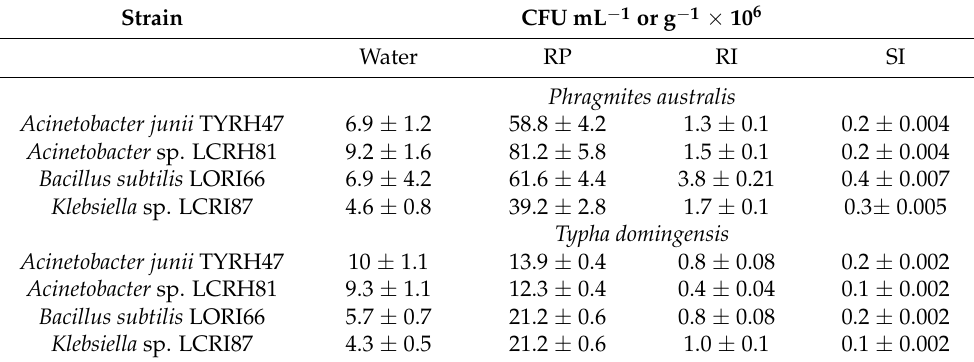
Table 3. Total colony forming units (CFU) of the 4 added bacterial strains after 36 days in the water, rhizoplane (RP), root interior (RI), and shoot interior (SI) of Phragmites australis and Typha domingensis in the FTWs. At day zero the water had been inoculated with 0.25 × 10 6 CFU mL − 1 of each strain.